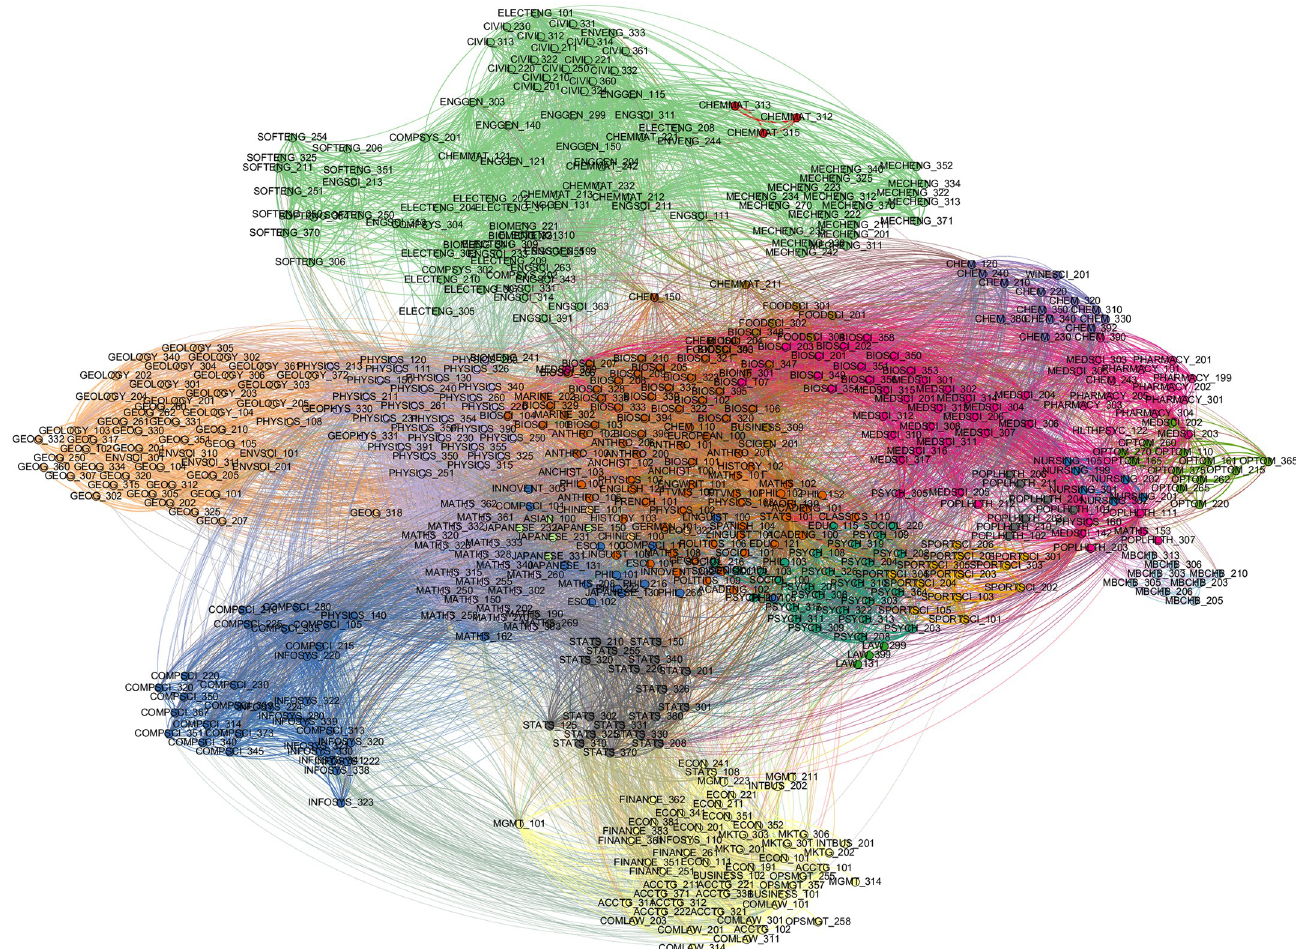
Fig 2. Student course network. A network representing the communities, or fields, of courses formed by students co-enrolling in course at the University of Auckland. Each node represents a course offered by the university, while links between nodes indicate instances where students took those two courses together within their undergraduate degree. Node colour indicates the community that a course belongs to. Communities were revealed in a two step process. Firstly, edges were filtered so only those with an RCP value over 1 were included. Secondly, the Map Equation software package [70] was used to partition the network into communities of courses, which can be interpreted as the underlying academic fields. The revealed fields are labeled in Fig 3, and represent the various academic fields that students in our sample were enrolled